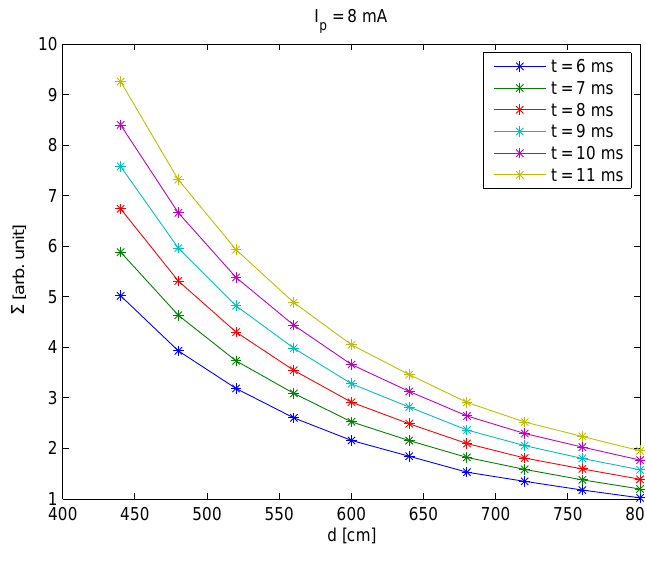
Figure 7. Values of (cid:6) obtained for I distances from 440 to 800